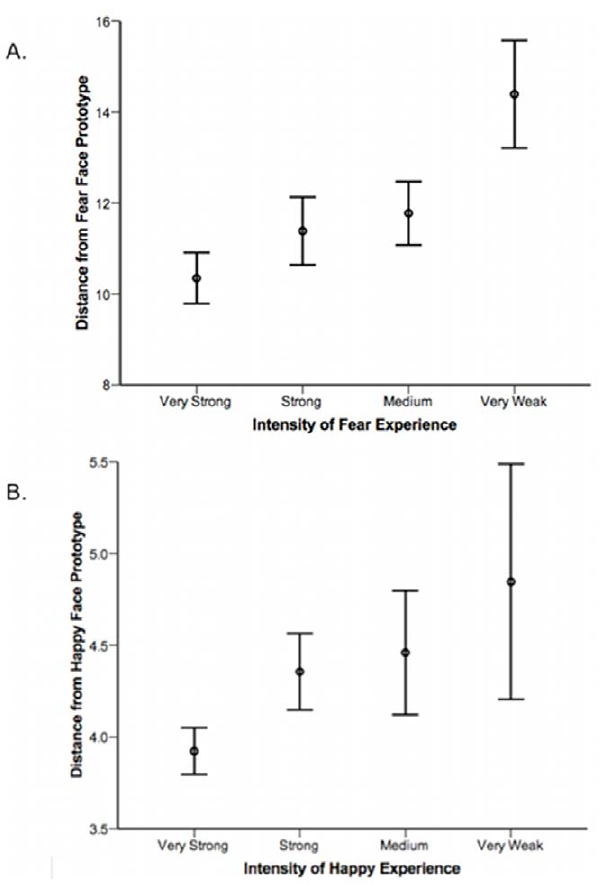
Figure 2. Emotional Experience is Associated with Facial Affect Recognition. Association between the intensity of emotion experi- ence (x-axis) and recognition of facial affect (y-axis). Data show the mean and 95% confidence intervals for the absolute value of the distance from the prototypical expression for each experience group. A: fear; B: happiness.